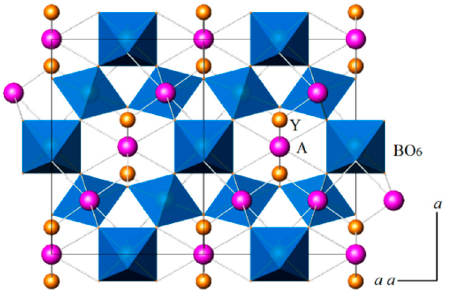
Figure 1. Schematic diagram of the crystal structure of the pyrochlore supergroup minerals.